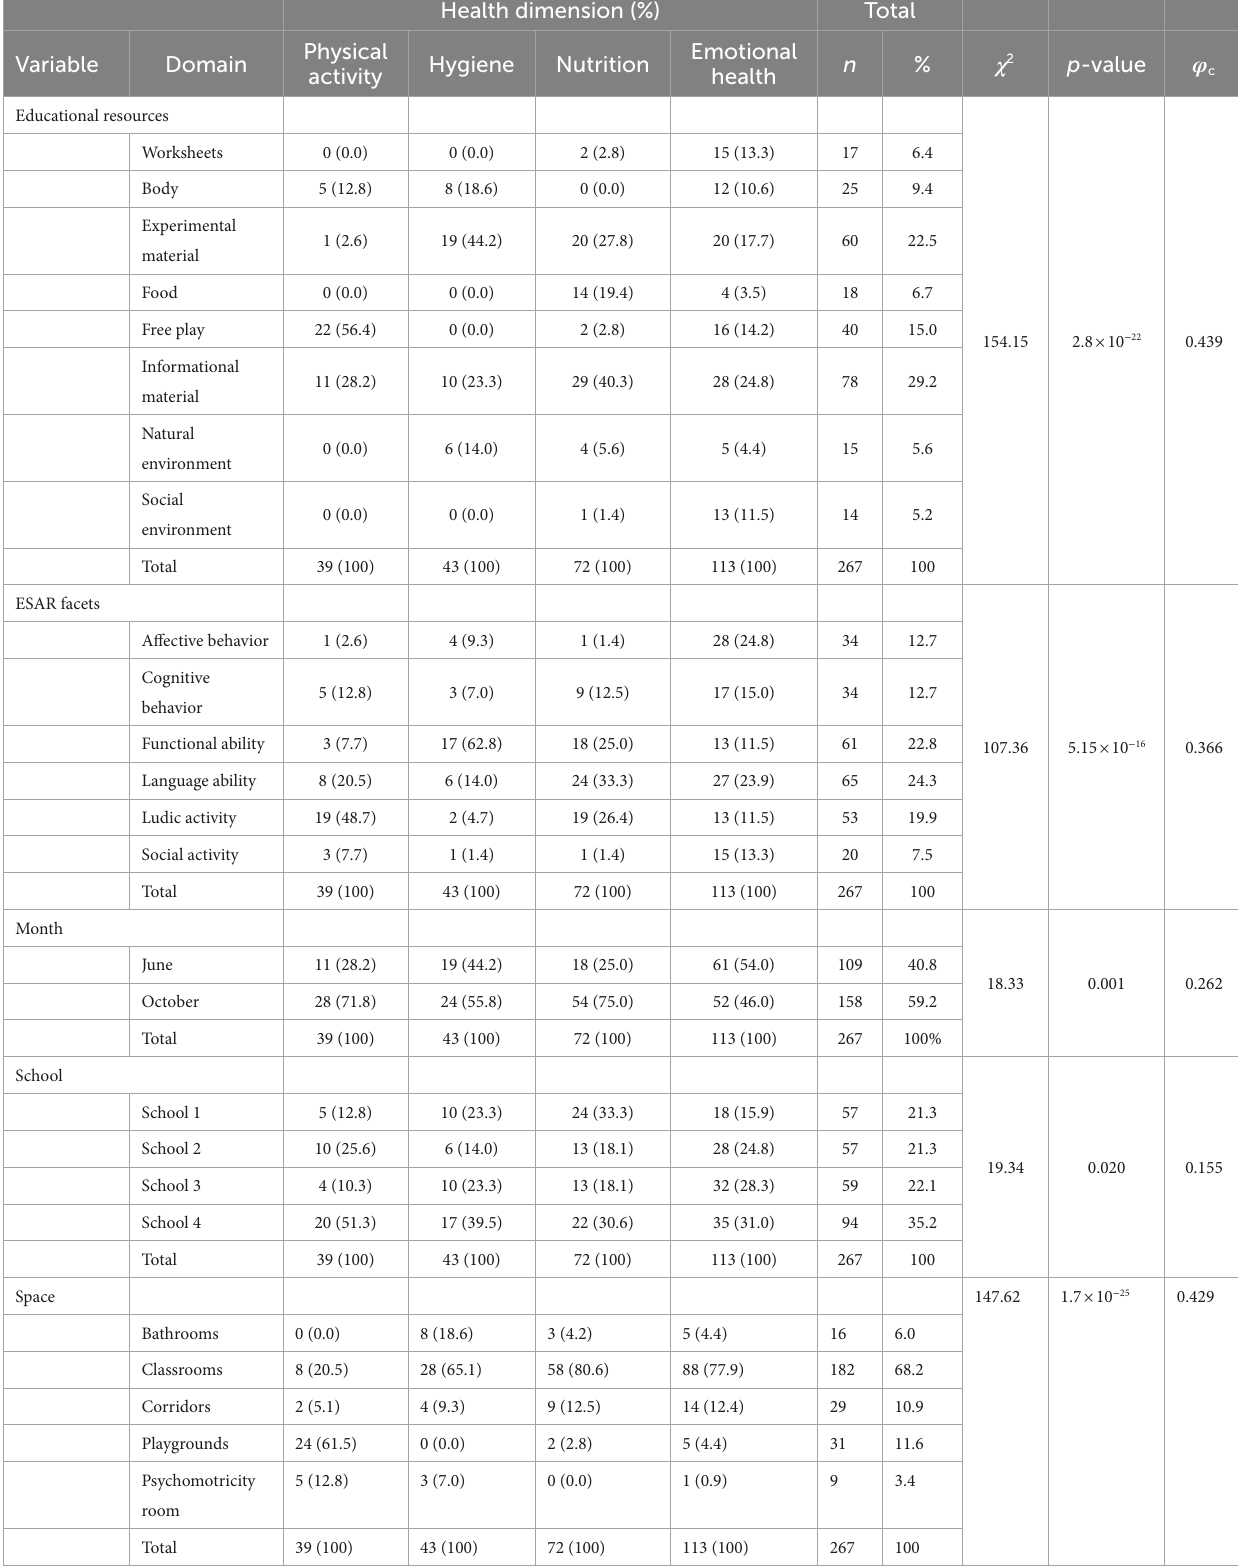
TABLE 1 Cross-tabulation of the study independent variables with the health dimensions. Health dimension (%)